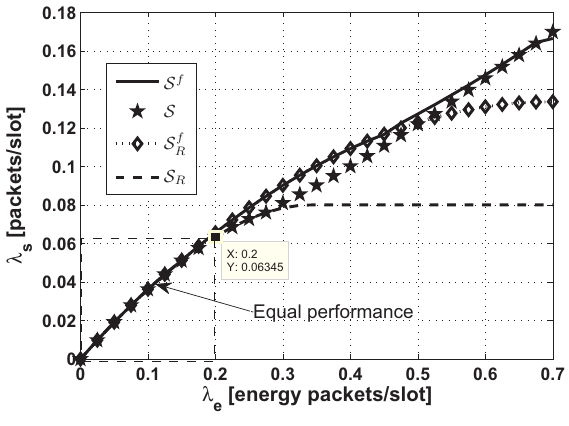
Figure 7. Stability region of system S for different values of the primary receiver MPR capability.